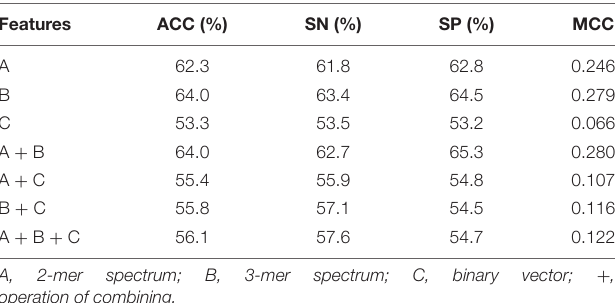
TABLE 1 | Five-fold cross validation results of different features and their combinations.